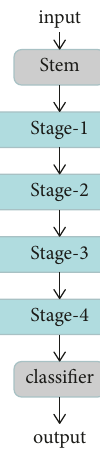
Figure 1: The original structure of the ResNet.